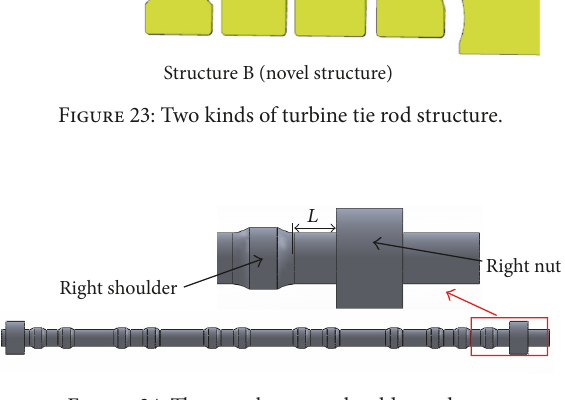
Figure 24: The span between shoulder and nut.